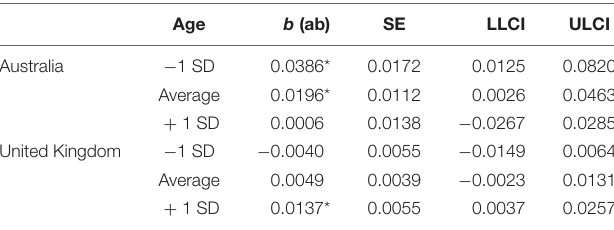
TABLE 3 | The conditional indirect effect of gender on achievement through deep learning at values of age. Age b (ab) SE LLCI ULCI